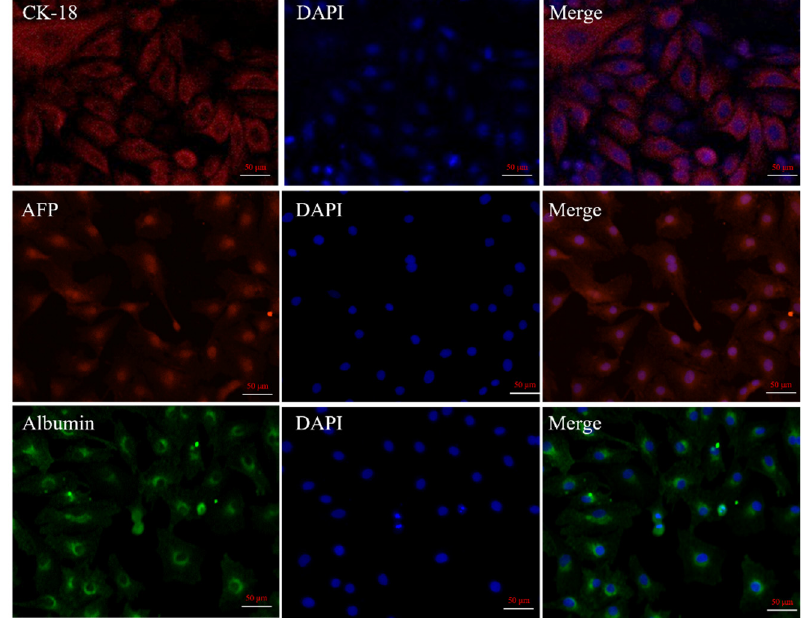
Figure 6. Characterization of resuscitated hepatocytes. Immunofluorescence analysis of resuscitated liver cells using antibodies corresponding to hepatocyte-specific marker cytokeratin 18, AFP, and albumin. Note: CK-18 and AFP are indicated with red fluorescence, albumin is green fluorescence, and DAPI is blue.